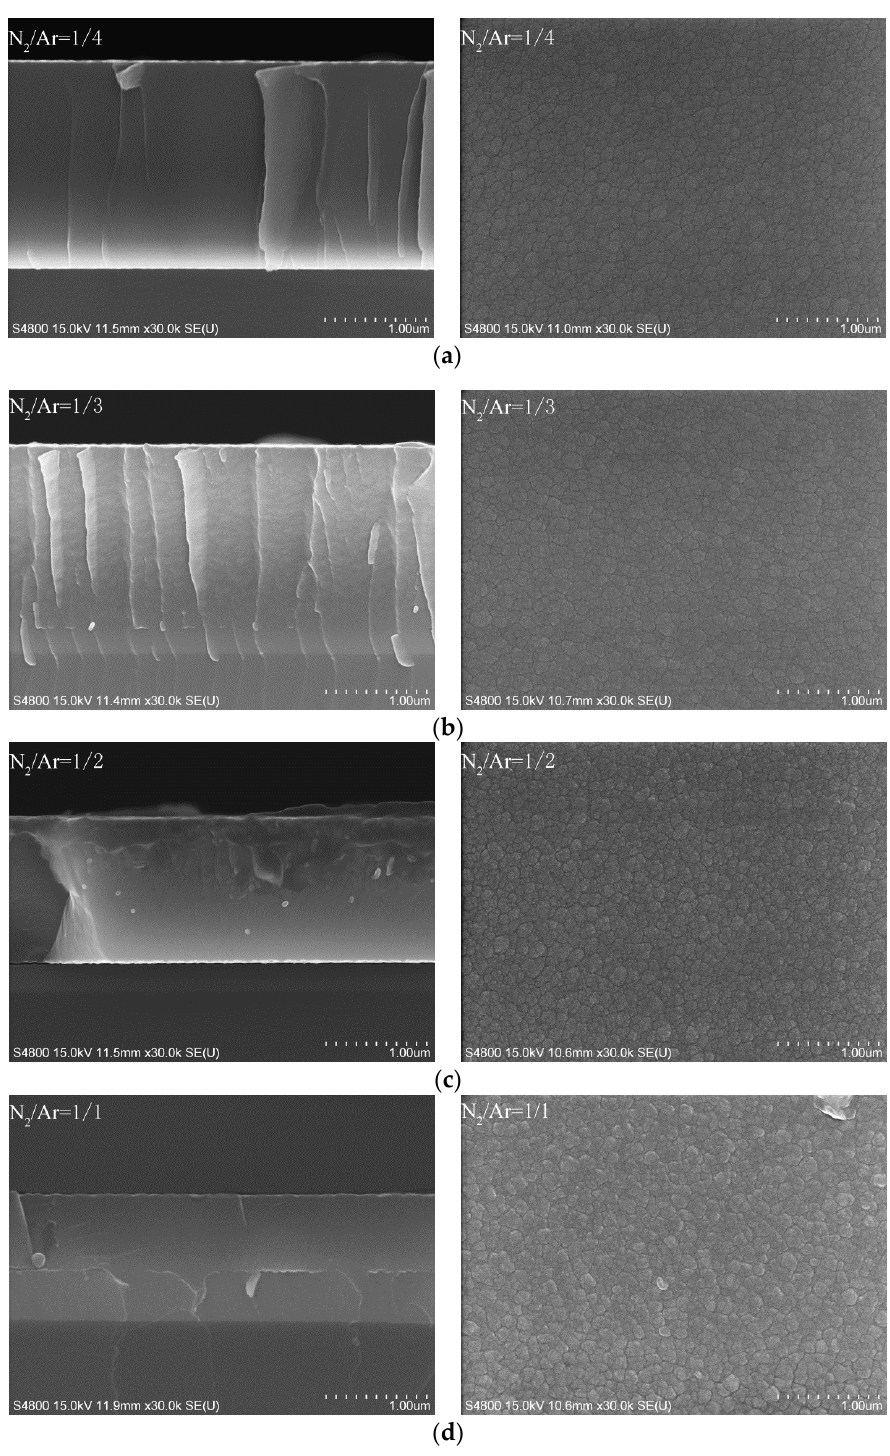
Figure 4. SEM cross-sectional and corresponding surface images of Al-Cr-Si-N coatings as a function of N 2 /Ar flow ratio: ( a ) N 2 /Ar = 1/4; ( b ) N 2 /Ar = 1/3; ( c ) N 2 /Ar = 1/2; ( d ) N 2 /Ar = 1/1.